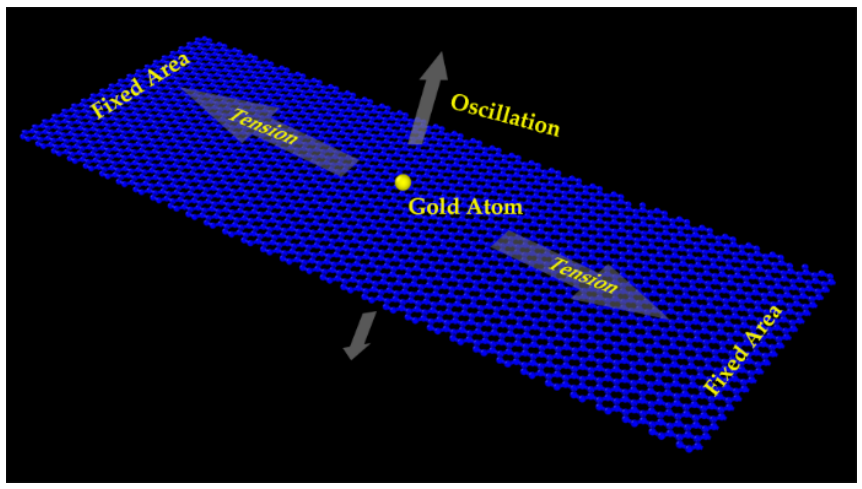
Figure 1. Atomic schematic of doubly clamped monolayer graphene resonator for classic molecular dynamics (MD) simulation.